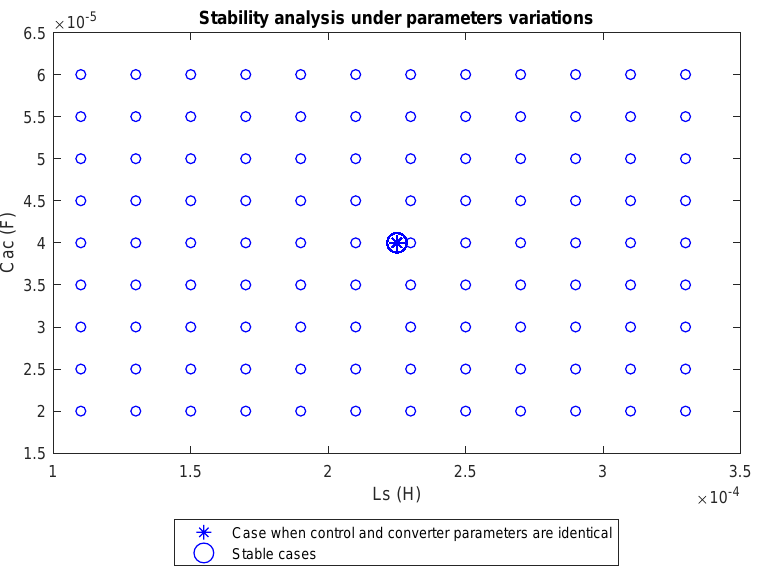
Figure 7. Stability analysis under parameter variations (inductance and capacity of AC filters are changed). Parameters are listed in Tables 1 and 3, and the operating point corresponds to Test I in Table